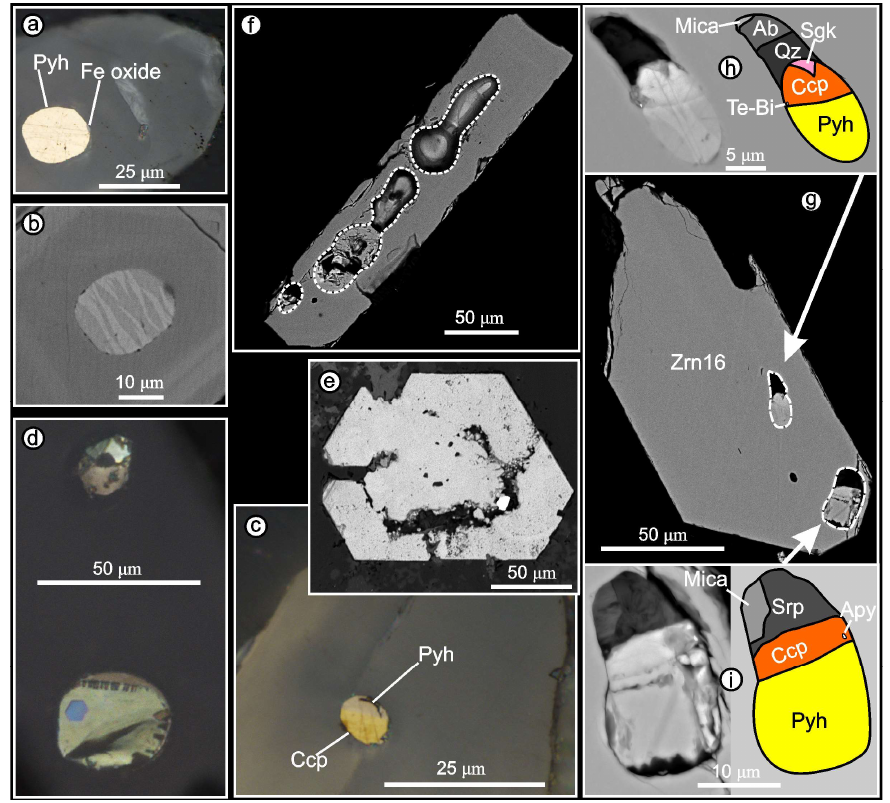
Figure 19. Mineral paragenesis of inclusions in zircon and mineral features.